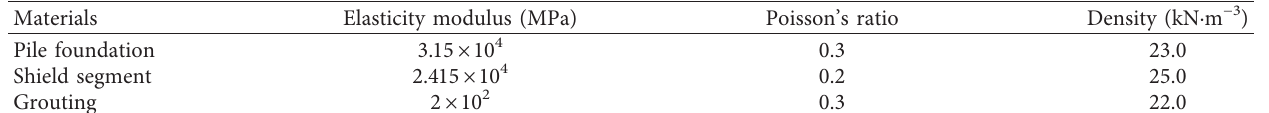
Table 3: Parameters of pile, segment, and grouting material.